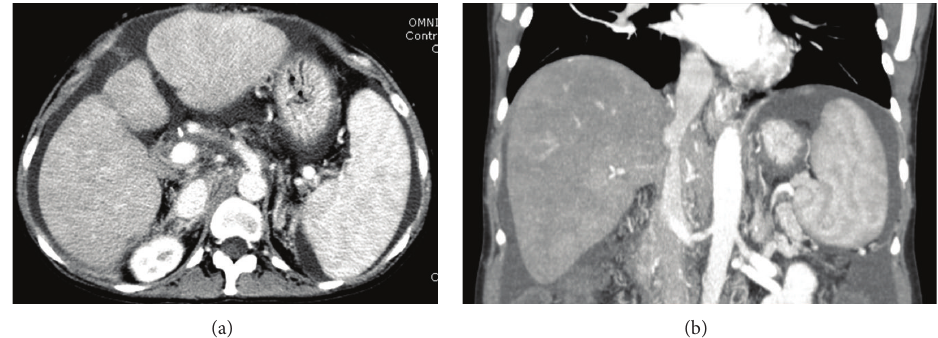
Figure 1: (a) Axial and (b) coronal contrast-enhanced CT of the upper abdomen obtained at admission shows a liver of cirrhotic morphology and nodular contours with mild diffuse heterogeneous enhancement. Splenomegaly, partly visualized ascites, and gastroesophageal varices are also noted. These findings were consistent with cirrhosis and sequela of portal hypertension. Numerous surgical clips about the porta hepatis represent changes of orthotopic liver transplantation.